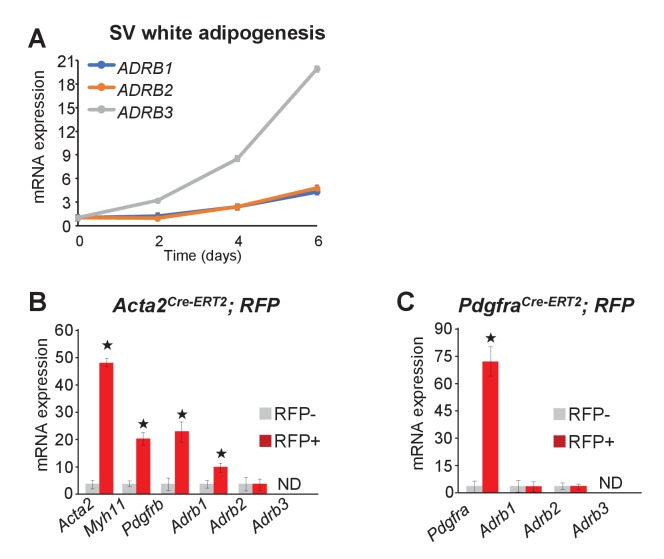
Adrb expression.(A) SV cells were isolated from two-month-old male mice and given white adipogenic media for 6 days. mRNA was harvested at denoted times and Adrb1, 2, and 3 expression was assessed throughout adipogenesis (n= 4/group in triplicate). (B) TM pulsed (Acta2Cre-ERT2; RFP) Acta2-RFP+ cells were FACS isolated from the WAT SV compartment and mRNA expression of denoted genes were examined (n= 6/group in triplicate). ★p<0.001 unpaired t-test, two tailed: RFP+ compared to RFP- cells. (C) TM-pulsed (PdgfraCre-ERT2; RFP) Pdgfra-RFP+ cells were FACS isolated from the WAT SV compartment and mRNA expression of denoted genes were examined (n= 6/group). ★p<0.001 unpaired t-test, two tailed: RFP+ compared to RFP- cells. All data are means ± SEM.